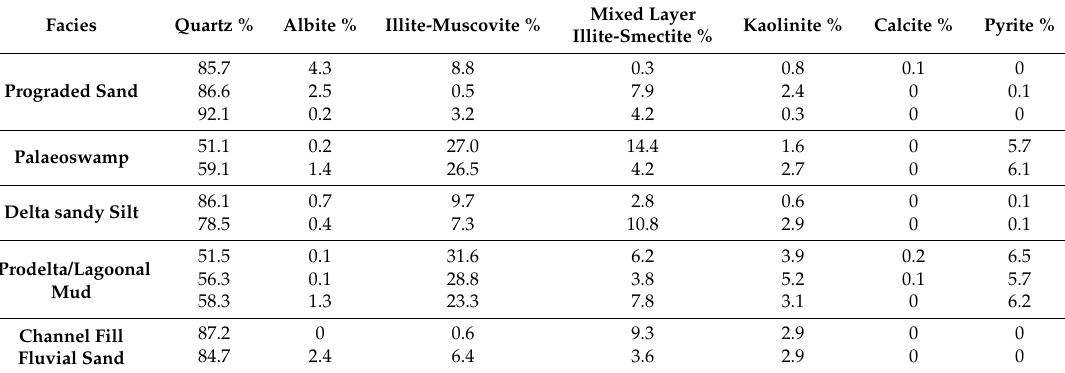
Table 2. X-ray diffraction analyses of sediment samples from the Wandandian Delta showing mineral proportions (after [15]).